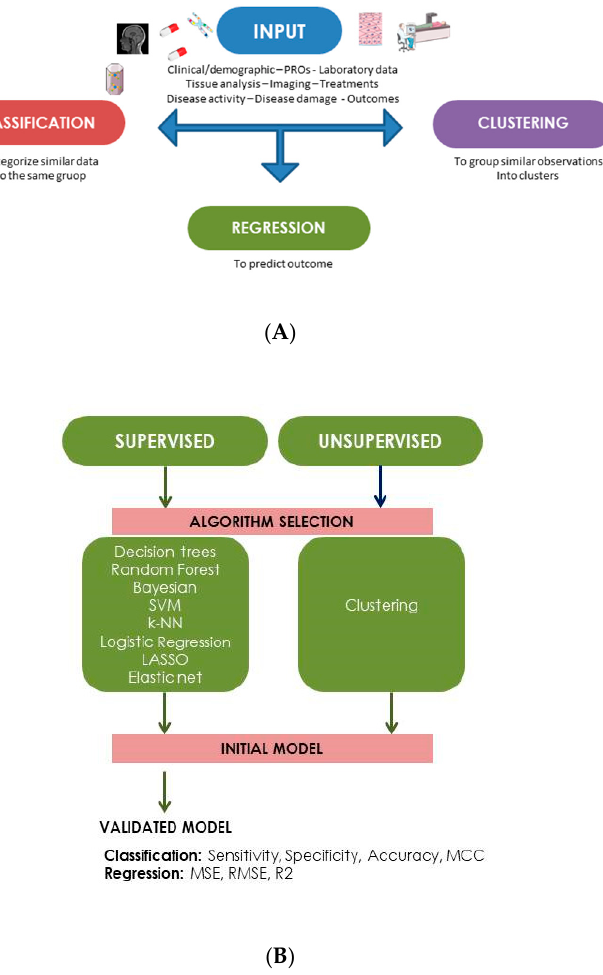
Figure 2. ( A ) Summary of input data used in machine learning models for medical studies, aiming at evaluating the following outcomes: classification, regression or clustering. ( B ) Summary of the different MLMs that could be applied in the supervised and unsupervised modalities.